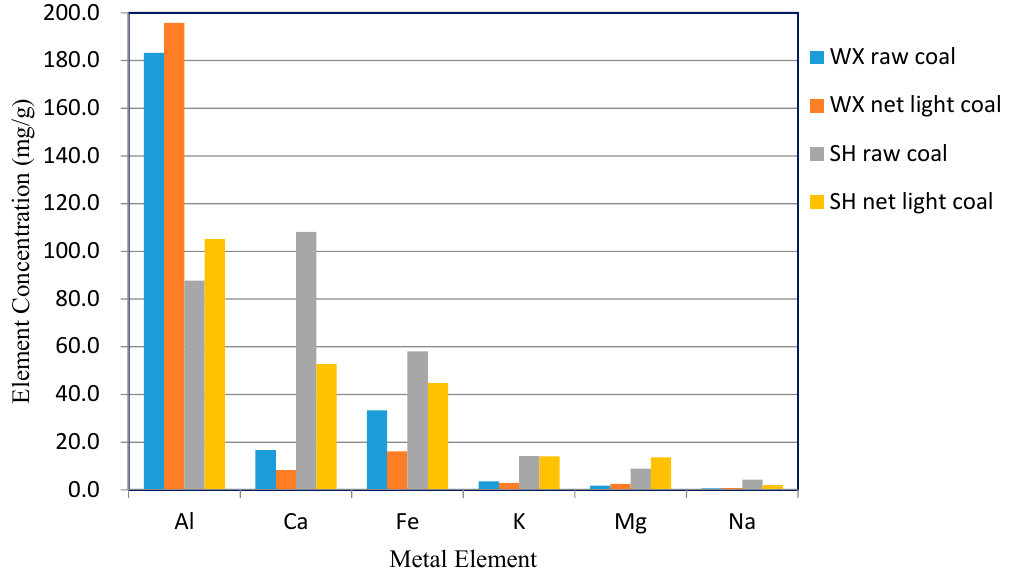
Figure 2. Major metal concentrations in 815 °C ash of raw coals and net light coals determined by ICP-AES (Left, WX coal ash; Right, SH coal ash).